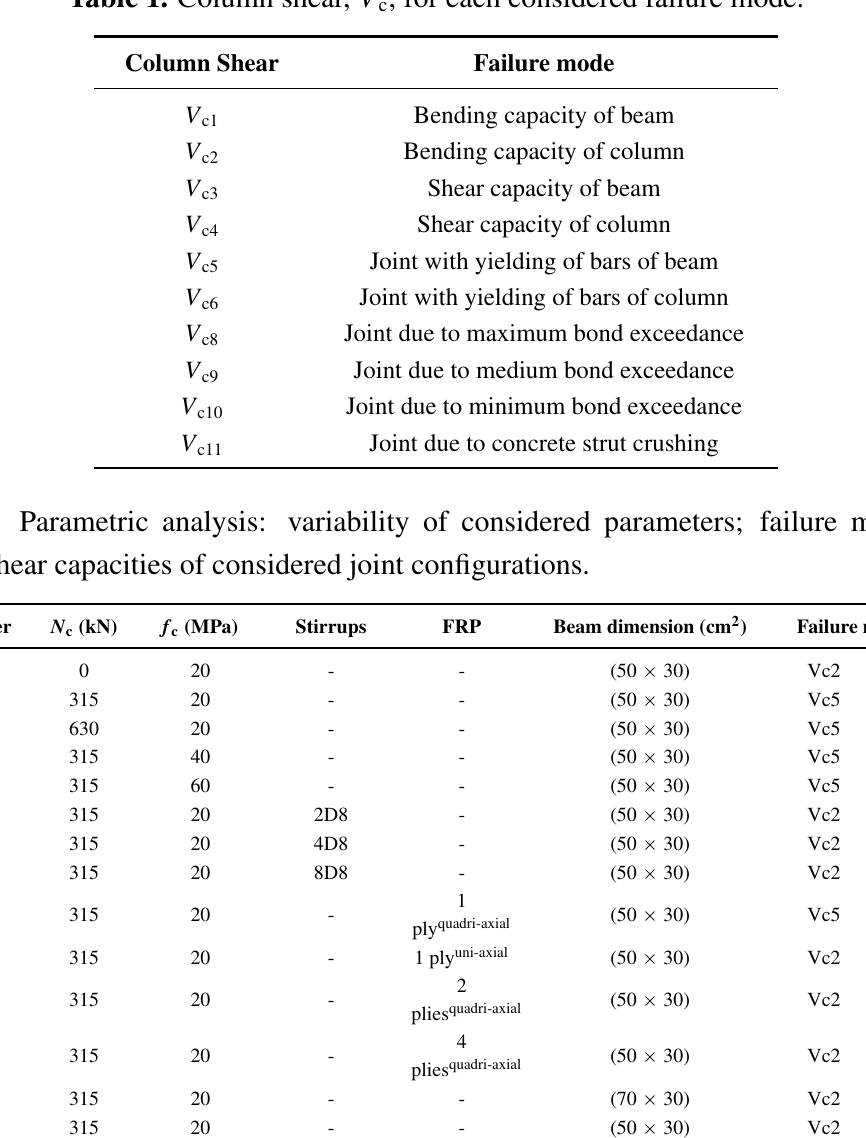
Table 1. Column shear, V